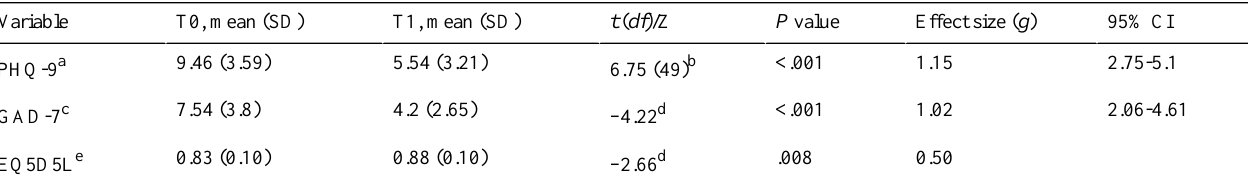
Table 4. Pretreatment and posttreatment assessment for PHQ-9, GAD-7, and